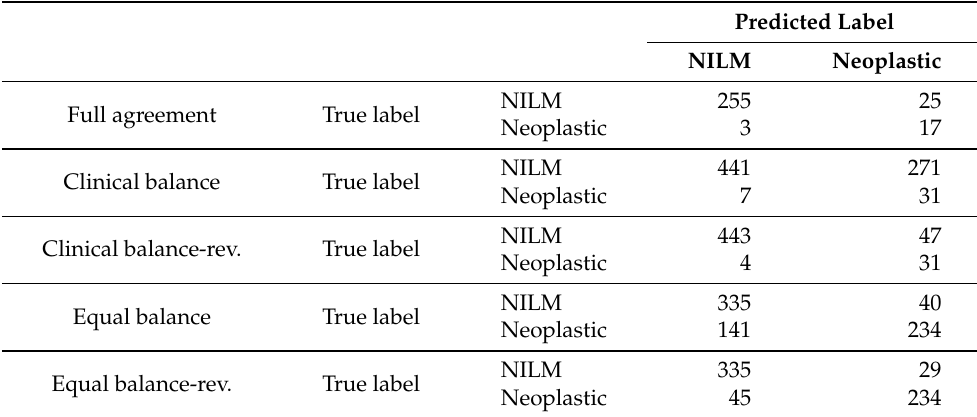
Table 3. Confusion matrix.